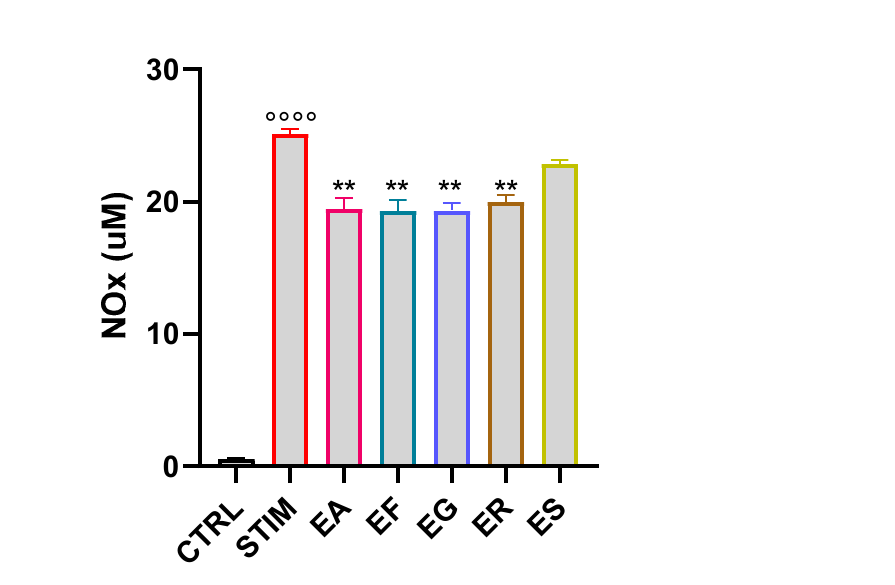
Figure 7. Eucalyptus Eos’ inhibition of NOx production. The J774A.1 macrophages were pretreated with the EOs (10 µg mL − 1 dissolved in DMSO) for 1 h before being stimulated with LPS (100 ng/mL) and INF γ (20 ng mL − 1 ). NO levels were measured in the cell culture medium after 24 h by the Greiss reaction. Values are expressed as mean ± SEM from three independent experiments. °°°° p < 0.0001 indicates the significant effect of LPS/INF- γ -stimulated cells compared to unstimulated cells (CTRL); ** p < 0.01 indicates a significant effect of the EOs compared to stimulated cells. EA = E. alba , EG = E. eugenioides, EF = E. fasciculosa, ER = E. robusta and ES = E. stoatei .